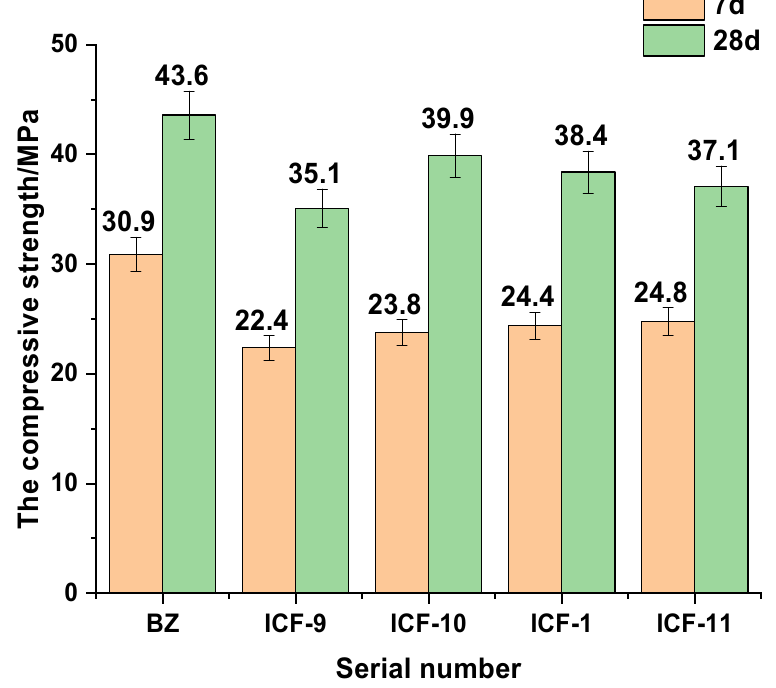
Figure 5. Compressive strength tests with different activator doping.